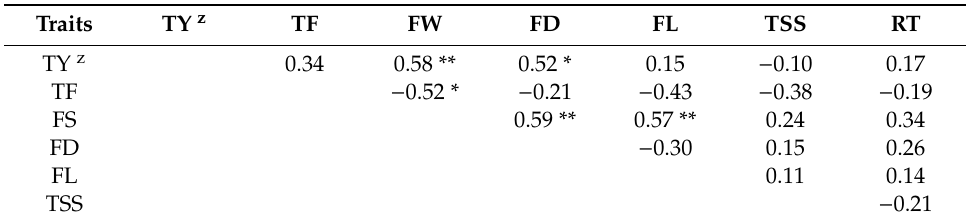
Table 3. Pearson’s correlation between yield parameters on twenty genotypes evaluated at Uvalde and Weslaco, TX in 2018 and 2019. Traits TY z TF FW FD FL TSS RT TY z 0.34 0.58 ** 0.52 * 0.15 − 0.10 0.17 − 0.52 * − 0.30 0.11 0.14 TSS −